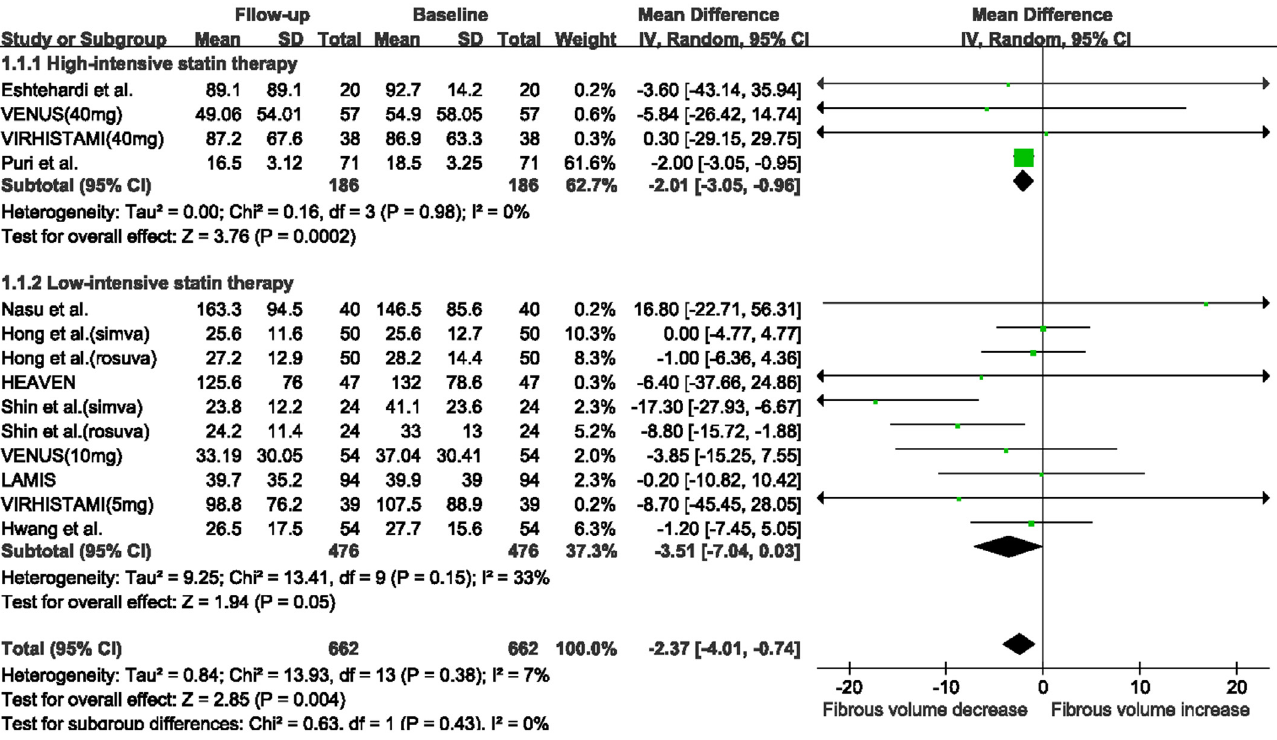
PLOS ONE | DOI:10.1371/journal.pone.0133433 July 30,